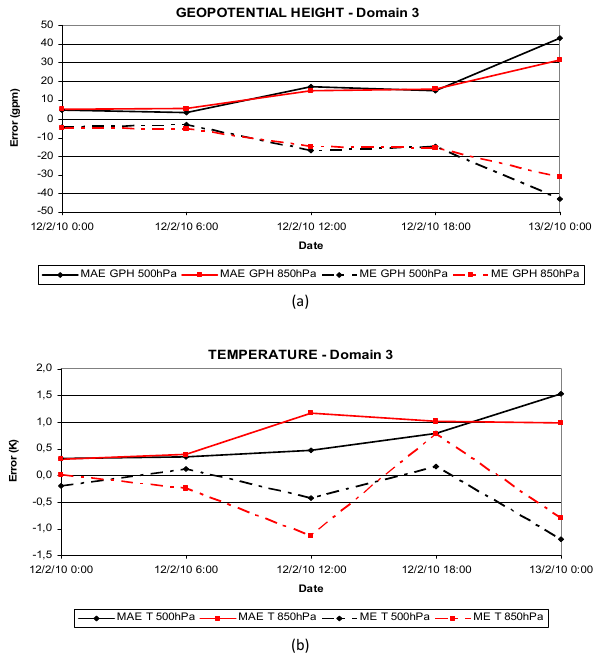
Figure 5: All statistics (Mean Absolute Error -MAE and Mean Error -ME) were calculated in 2 Figure 5. All statistics (Mean Absolute Error – MAE and Mean the inner domain (D3) through the comparison of ECMWF gridded analyses and WRF 3 Error – ME) were calculated in the inner domain (D3) through the forecasts for Geopotential Height at 500 and 850 hPa (a) and for temperature at 500 and 850 4 comparison of ECMWF gridded analyses and WRF forecasts for hPa (b). 5 Geopotential Height at 500 and 850hPa (a) and for temperature at 500 and 850hPa (b) .